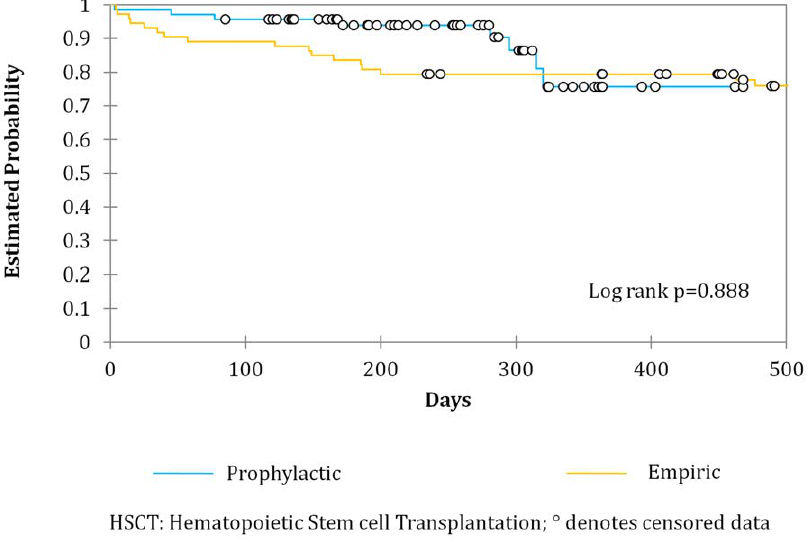
Figure 2. Overall Survival for patients undergoing allogeneic Hematopoietic Stem cell Transplantation receiving either a prophylactic or empiric antibiotic strategy.